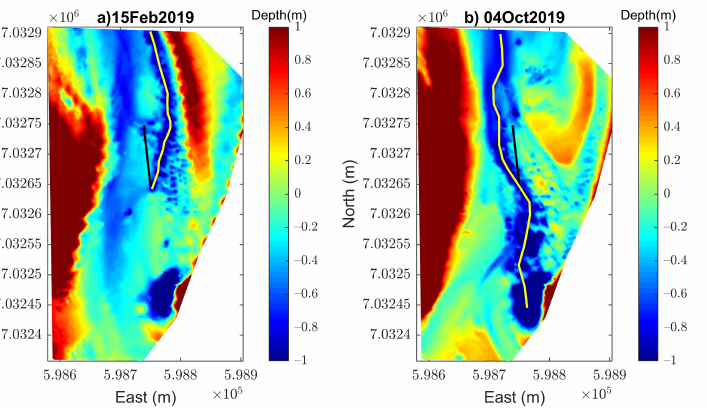
Figure 5. Detail bathymetry around the SND at: ( a ) 15 February 2019; ( b ) 4 October 2019. The yellow lines depict as the thalweg line of − 0.8 m of the main channel. The back lines depict the location of the